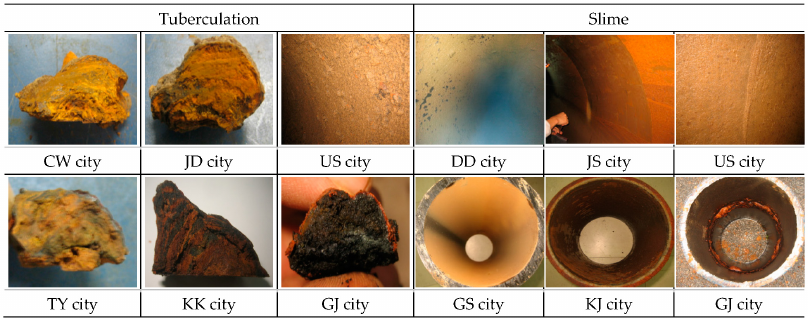
Figure 3. Selective samples of tubercles and slimes.